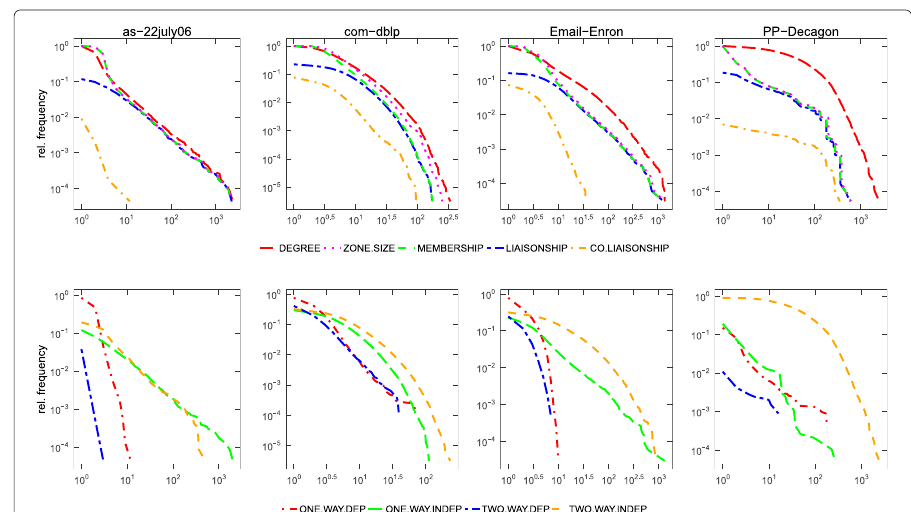
Fig. 11 Node and zone properties in real-world networks. The upper row shows that the distributions of zone-size, membership, and liaisonship roughly copy the shape of the node degree distribution. In as- 22july06 and PP-Decagon networks, there is a smaller fraction of nodes in the co-liaison role than in com-dblp and Email-Enron networks. From dependency properties at the lower row plots, it is evident, that PP-Decagon network has a higher proportion of nodes with two-way independent neighbors (TwIndep property)